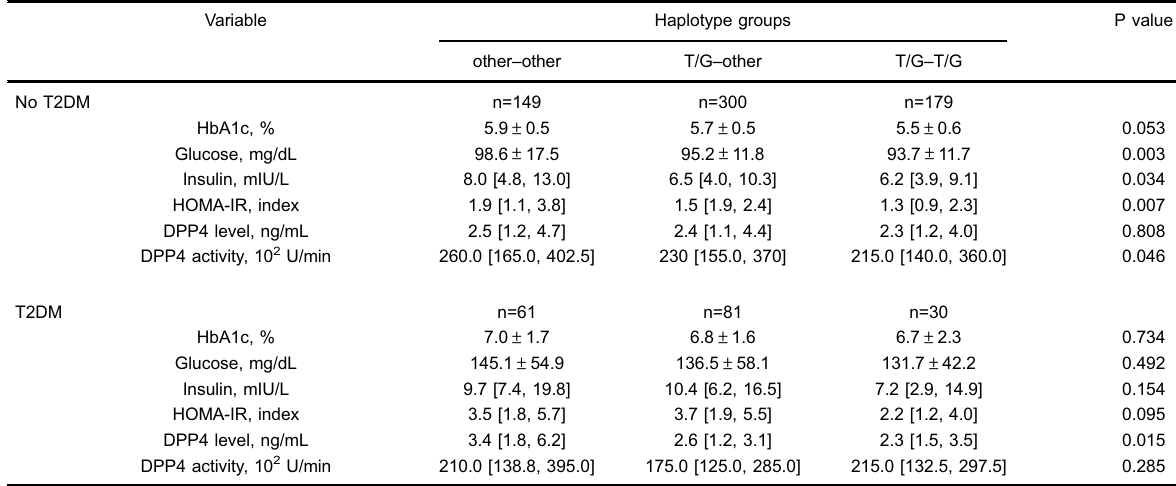
Table 2. Analysis of fasting glycemia-related variables according to the clinical condition of the subjects and haplotypes. Variable Haplotype